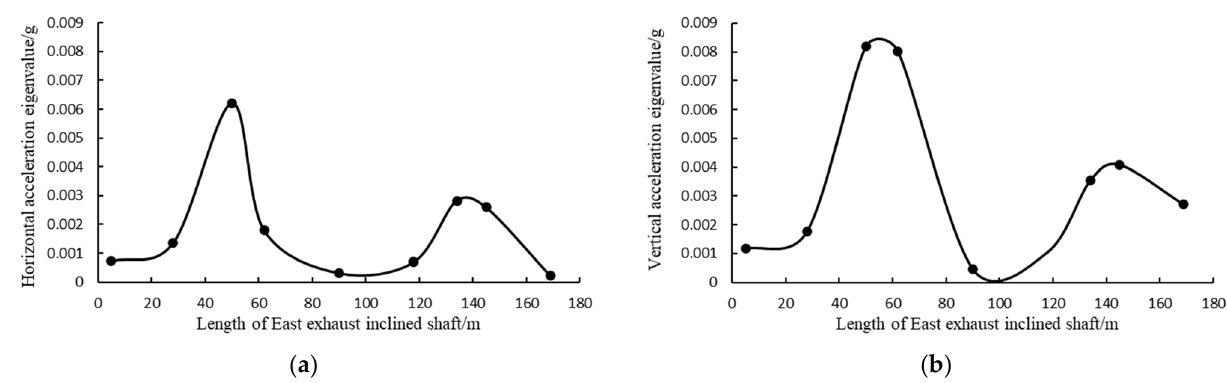
Figure 17. Schematic diagram of relation between acceleration and inclined shaft length of east exhaust inclined shaft. ( a ) Schematic diagram of relation between horizontal acceleration and inclined shaft length of east exhaust inclined shaft; ( b ) schematic diagram of relation between vertical acceleration and inclined shaft length of east exhaust inclined shaft.